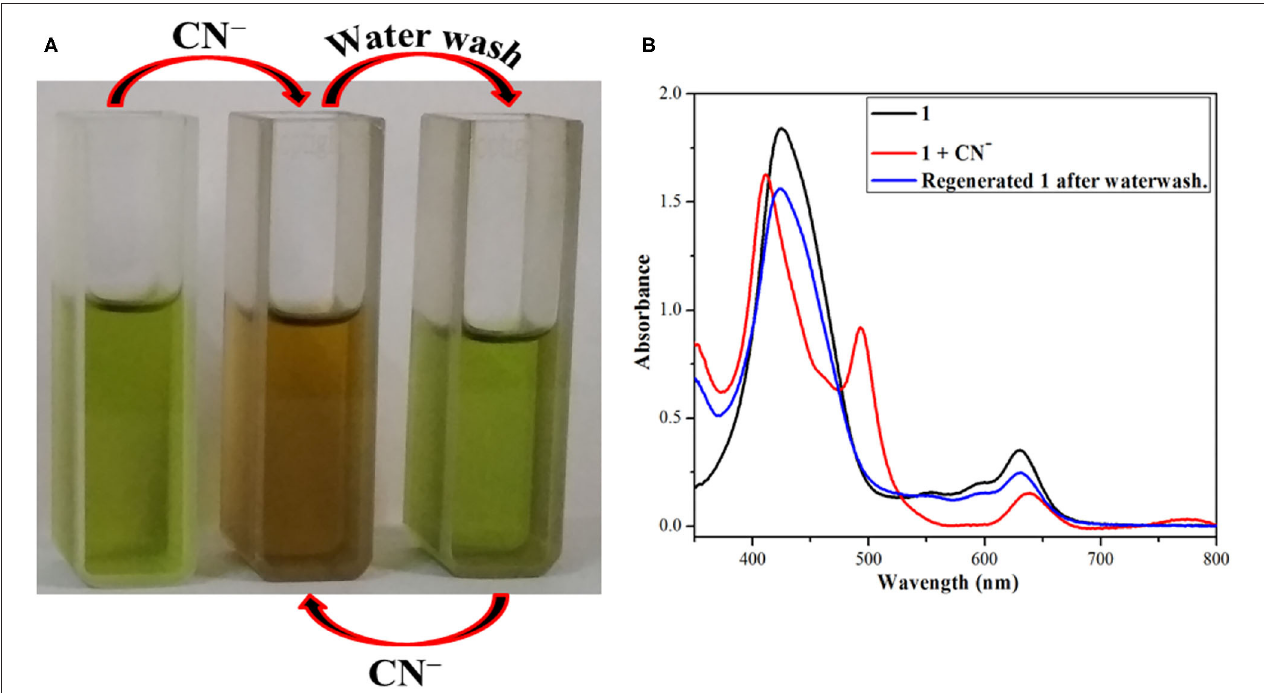
FIGURE 5 | Reversible nature of 1 after addition of CN − ions and followed by water washing (A) color changes (B) absorption spectral changes using dichloromethane and distilled water at